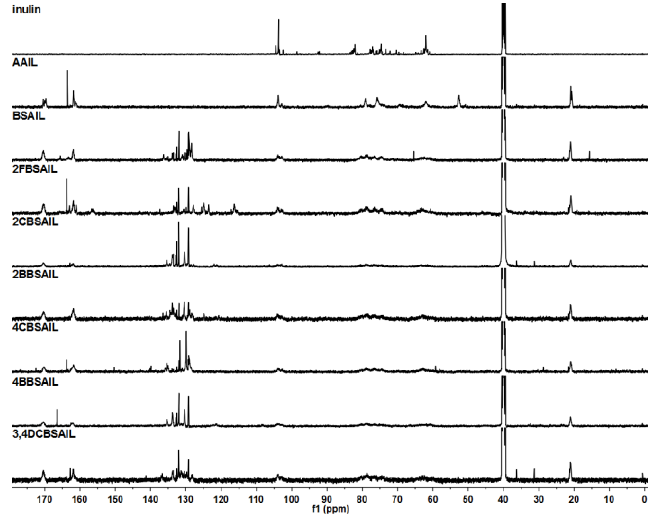
Figure 3. 13 C NMR spectra of inulin, AAIL, and inulin derivatives, recorded in DMSO-d6.